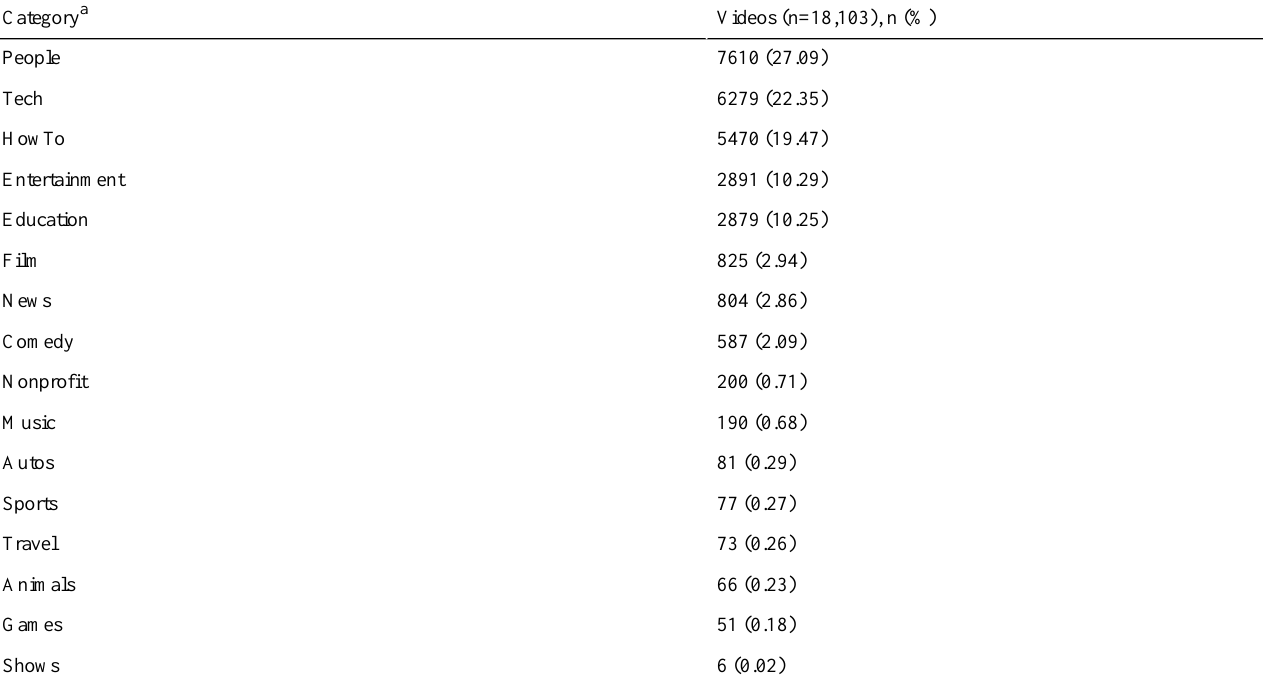
Table 2. Categories of e-cigarette-related YouTube videos with metadata as of June 30,